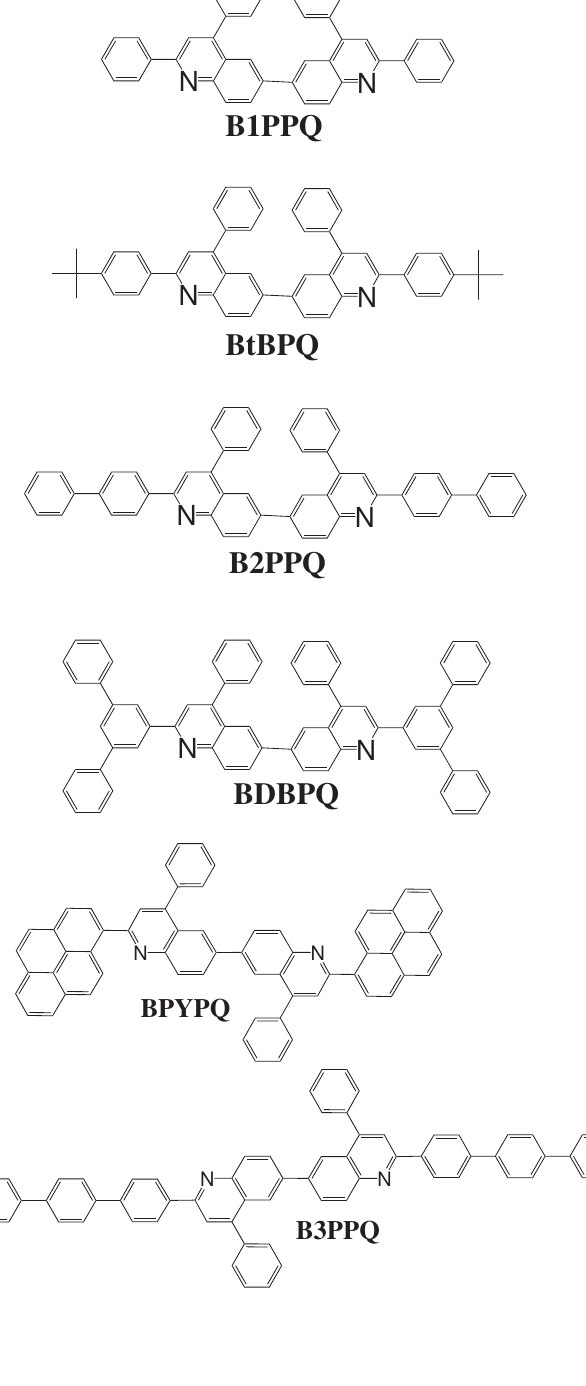
phase with those in chloroform solution, we find that, relative to the excitation energy in gas phase, there is a consistent redshift in excitation energy in solution, due to the solute-solvent interaction. Figure 1. Molecular structures of the computationally studied blue-light-emitting